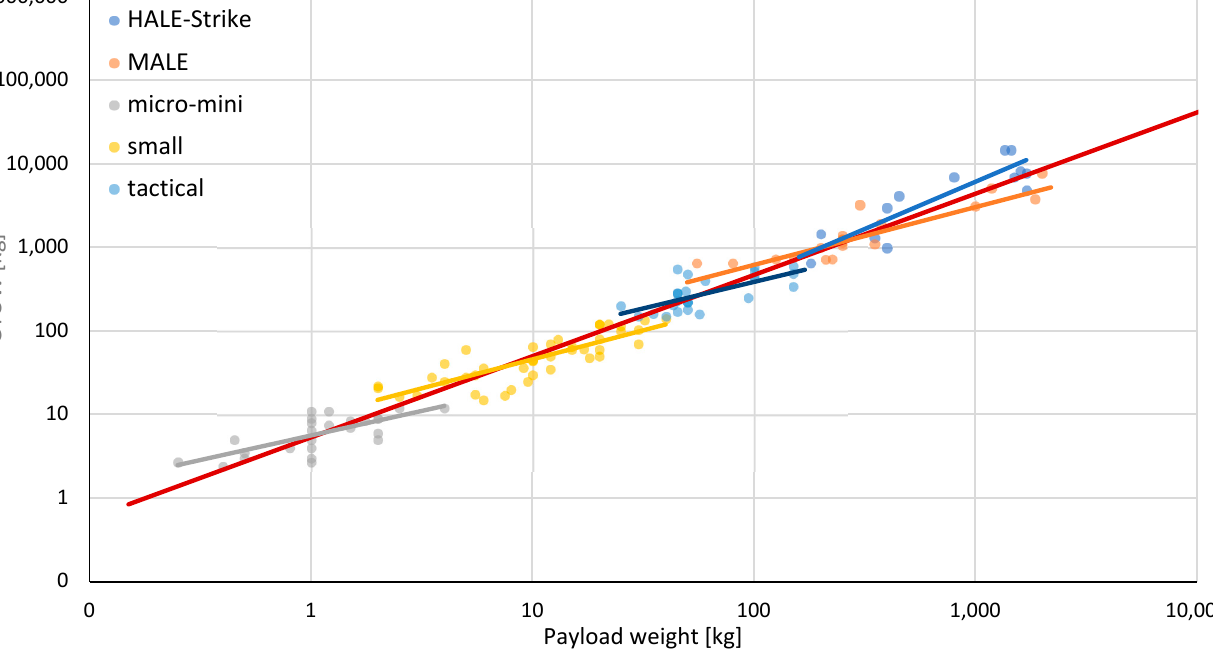
Figure 9. GTOW as a function of payload weight with respect to NATO classification. The color code is identical to the one described in Figure 6.